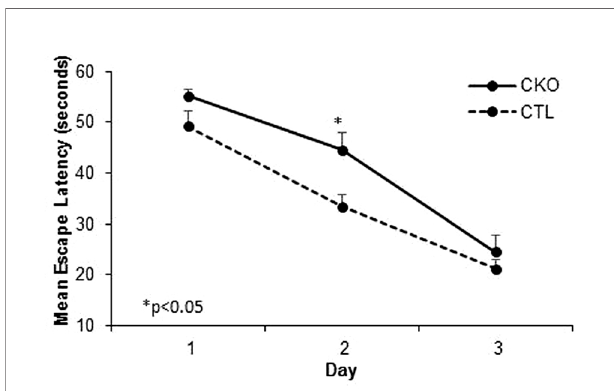
FIGURE 3 | Results of the Morris water maze (MWM). Cumulative escape latency in all 3 days comparing CKO and CTL mice. Data are presented as mean ± SD, *P